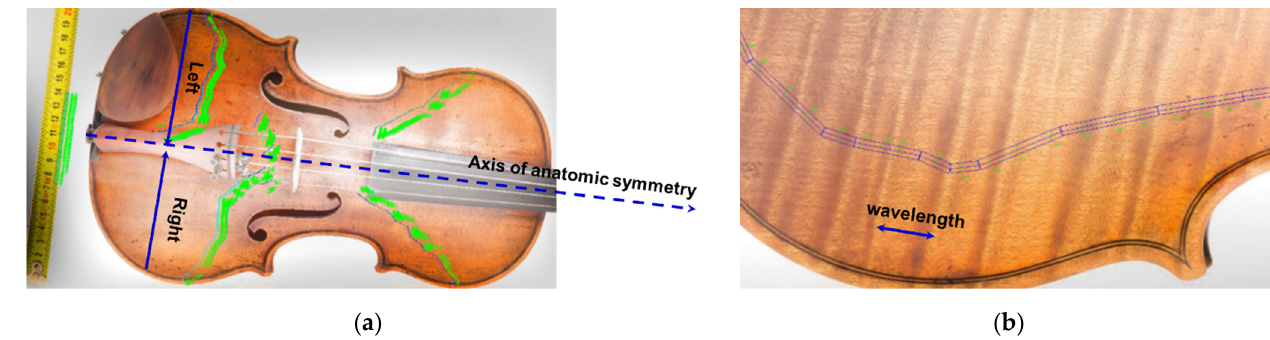
Figure 3. How to measure ring rings for the top plates/back plates of violins—case study of the Stradivarius Elder Voicu 1702 (photo courtesy of the “George Enescu” Bucharest Philharmonic and master violinist Tomescu Alexandru): ( a ) measuring the series of annual rings on the top plate; ( b ) measuring the wavelength of the curly fiber of maple from the back plate.